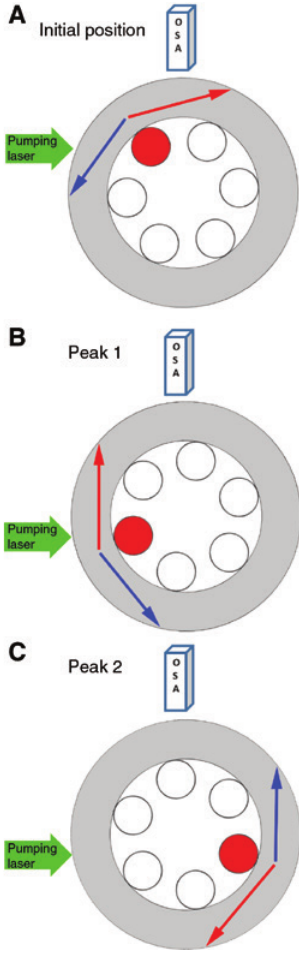
Figure 9: Sketches of possible orientations of the HC-NCF at (A) 0 ° , (B) 75 ° and (C) 210 ° corresponding to Figure